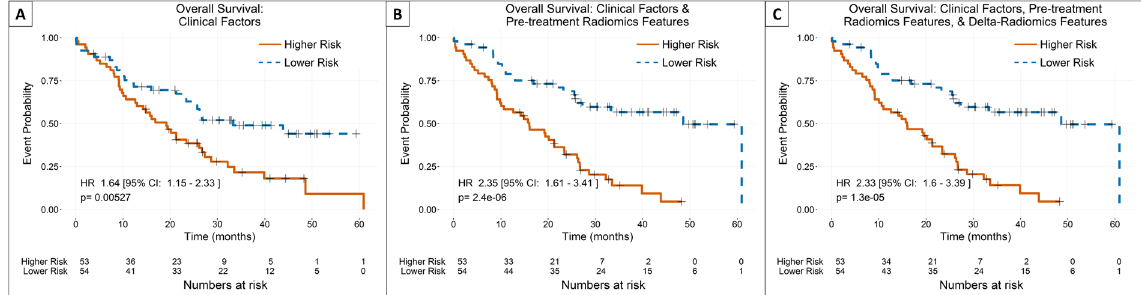
Figure 3. Comparison of Kaplan-Meier curves for overall survival using the three nested models with patients stratified by the median prediction value of each model. The stratification was significant for all three models. The addition of a pretreatment radiomics feature, compactness2, to clinical factors alone had a small improving effect on the stratification, while the further addition of delta-radiomics features had almost no impact on the stratification.